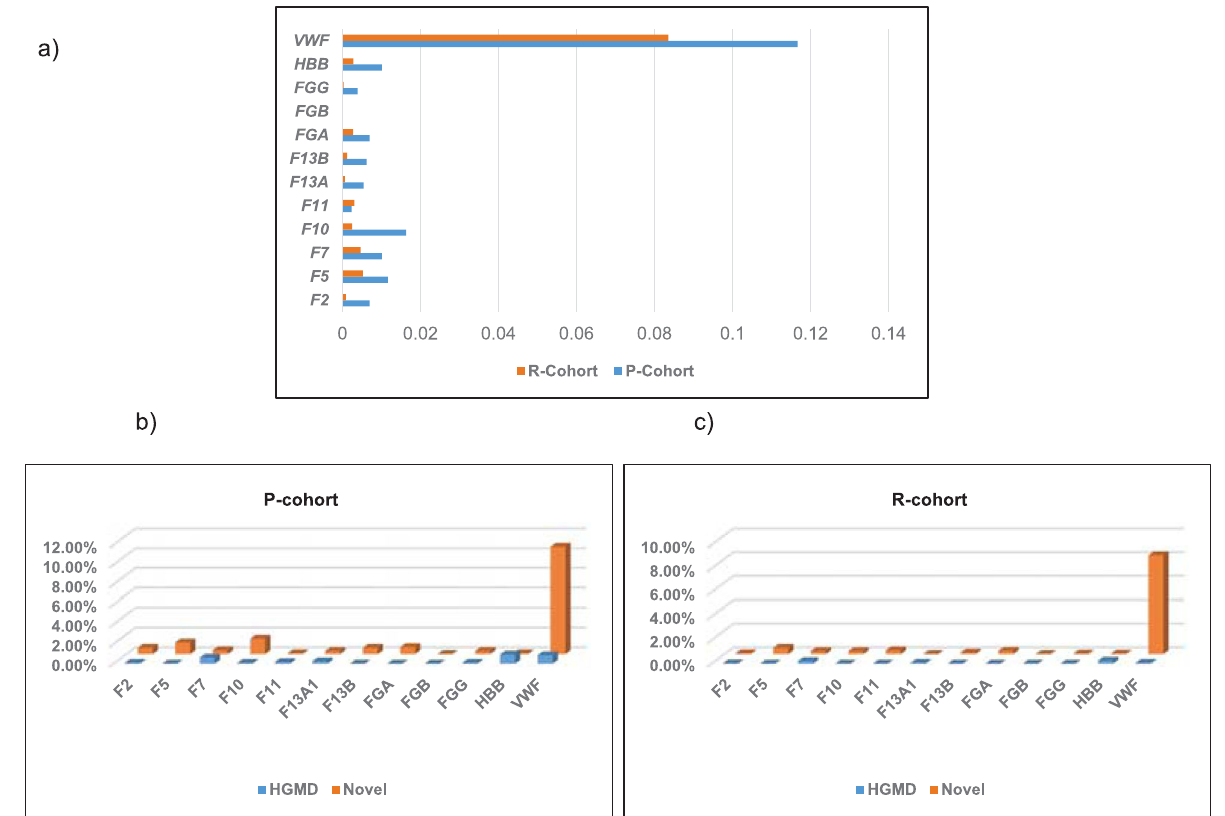
Fig. 2 Heterozygotes frequency in AR genes. a Carrier status for pathogenic, likely pathogenic and VUS/gene in both cohorts. b Percentage of HGMD and novel mutations carriers/gene for P-cohort. c Percentage of HGMD and novel mutations carriers/gene for R-cohort. (generated from Supplementary Tables 6 and